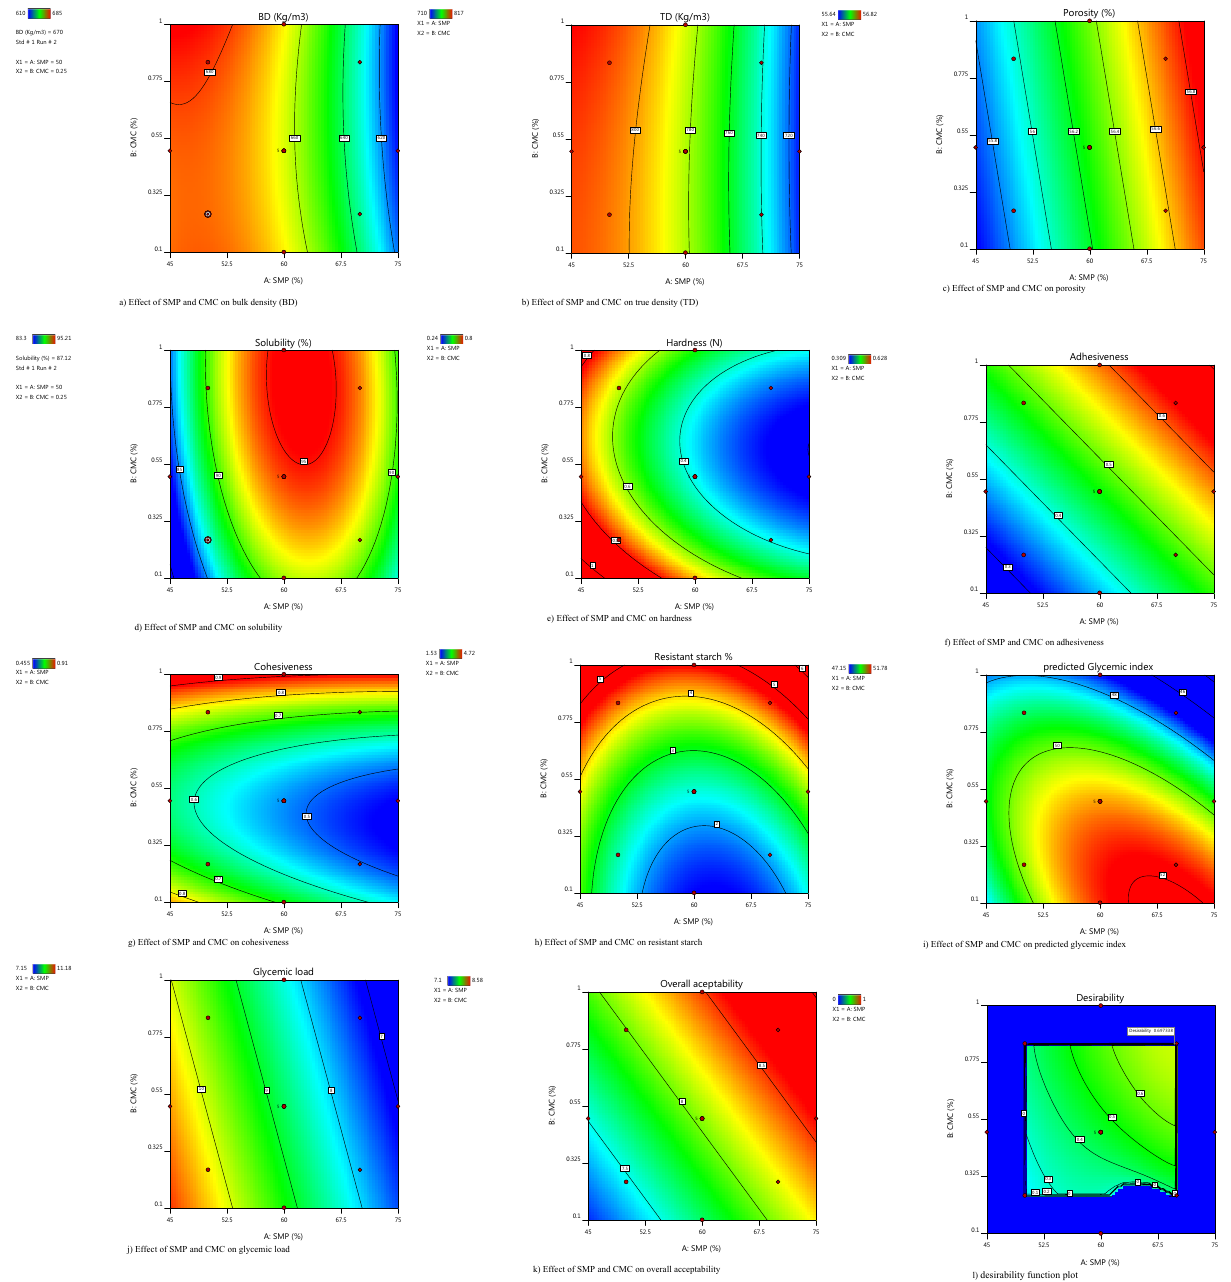
Figure 1. ( a – d ) Demonstrates the effect of skimmed milk powder (SMP): high amylose rice (HAR) and CMC on physical attributes of instant dry mix; ( e – k ) demonstrates the effect of SMP: HAR and CMC on textural parameters, resistant starch, kinetics of starch digestion and overall acceptability of instant dry mix phirni, and ( l ) optimization from such samples. At the highest concentration of rice flour (55%), maximum hardness was recorded highest (0.80 N), which could be attributed to interaction of SMP proteins with leached components of starch in phirni during cooling 40 . Amylose has an ability to form rigid gel, which may have caused interaction starch and milk causing positive affect on the firmness of puddings 41 . Figure 1e shows that B also had significant negative linear effect on hardness. As the concentration of CMC was increased from 0.1 to 0.5%, hardness decreased from 0.75 to 0.36 N. CMC has good holding capacity and thus decreases the gel hardness during cooking which subsequently leads to the production of soft puddings 42 . Adhesiveness and cohesiveness. Adhesiveness (ADH) indicates the ability of the product to adhere to the pal- ate during swallowing 43 while cohesiveness (COH) measures the strength of internal bonds and the degree to which a food can be deformed before it breakdowns 44 . Both ADH and COH are important factors which govern